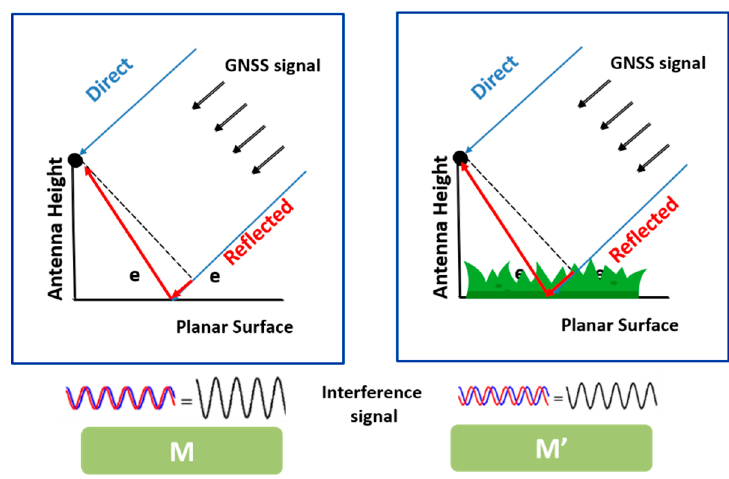
Figure A1. Schematic diagram of monitoring vegetation water content by Figure S1. Schematic diagram of monitoring vegetation water content by GNSS-IR.